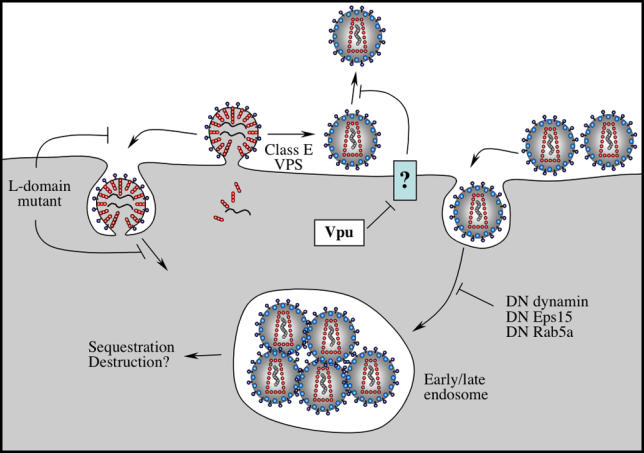
Model for the Role of Vpu in Retroviral Particle ReleaseRetroviral Gag molecules targeted to the PM (by unknown mechanisms) require the recruitment of class E VPS factors to enable budding of mature virions. At this point, nascent viral particles are subject to an unknown, subtilisin-sensitive, host-cell type-specific restriction (depicted as a question mark) that results in their retention at the cell surface. Subsequently, endocytosis by a dynamin-, EPS-15-, and Rab5a-dependent process result in intracellular accumulation in early/late endosomes, where they may be simply sequestered, or perhaps destroyed, in lysosomes. Vpu overcomes this restriction, leading to more efficient release of virions from the cell surface. In contrast, inhibition of endocytosis by DN mutants of dynamin, EPS-15, or Rab5a prevents the accumulation of virions in endosomes, but does not enhance virion release, suggesting Vpu inhibits a specific host-restriction activity, rather than imposing a generalized inhibition on endocytosis.